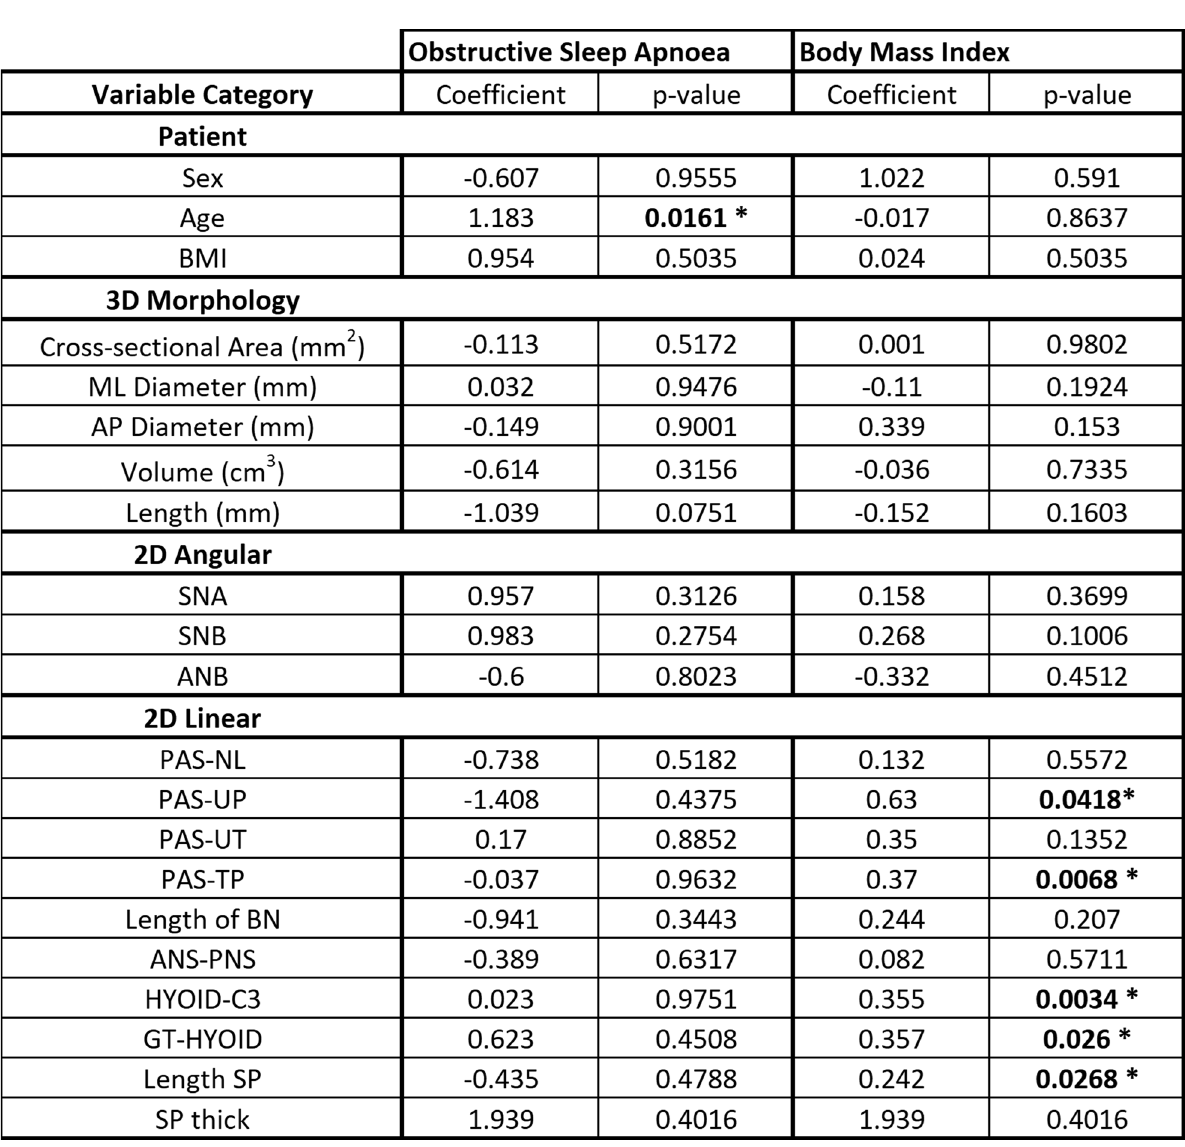
Table I outlines key descriptive statistics relating to airway measurements of the cohort of 32 obese patients with a history of OSA.